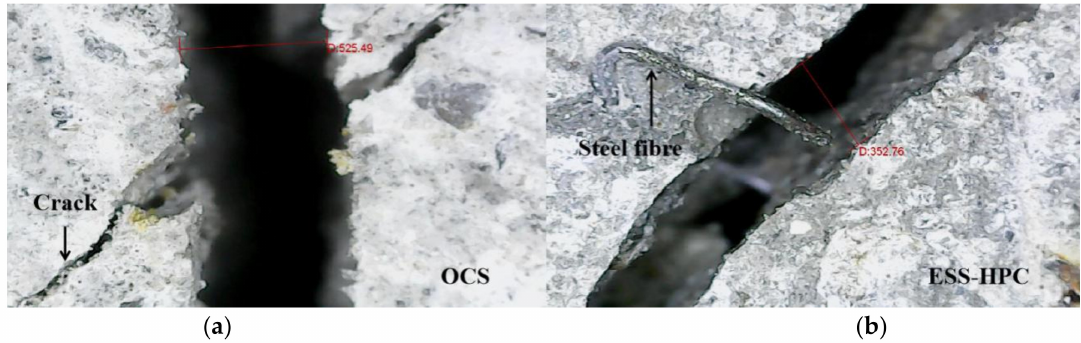
Figure 8. Crack width of the composite. ( a ) OCS; ( b ) ESS-HPC.